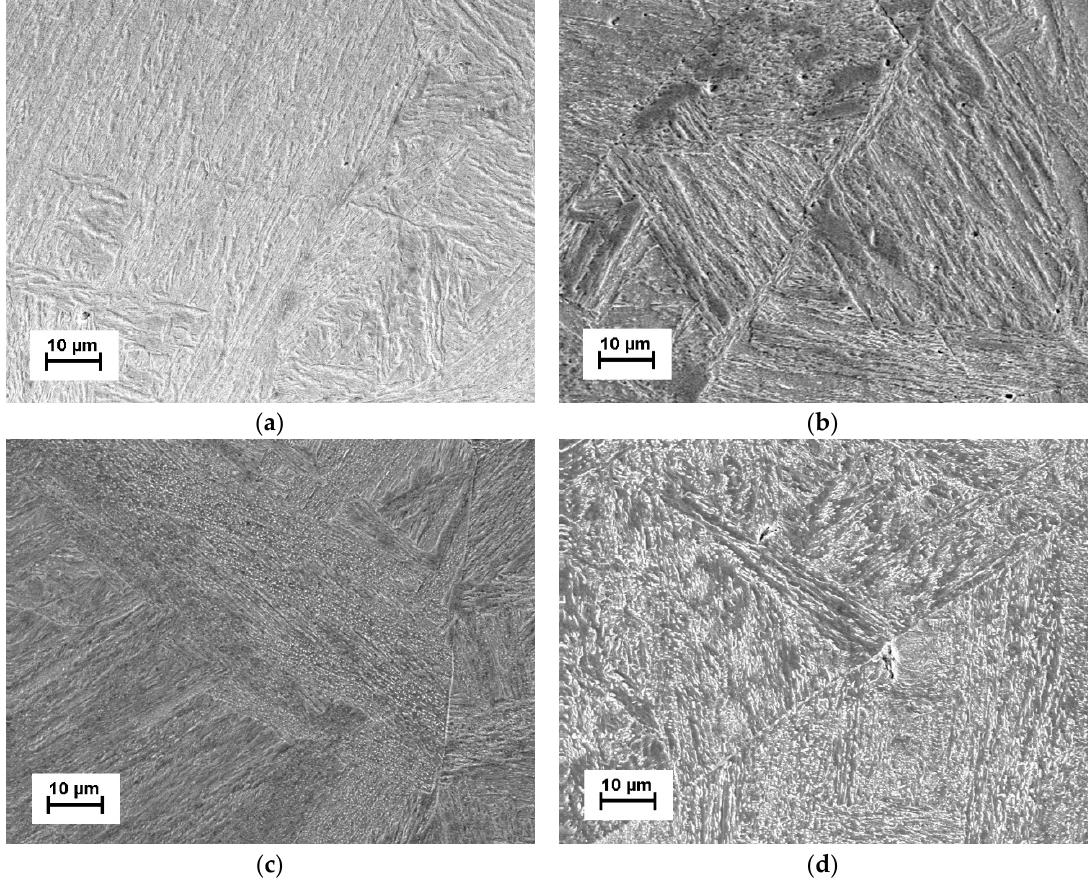
Figure 5. CGHAZ microstructure: ( a ) t 8/5 = 2.5 s; ( b ) t 8/5 = 15 s; ( c ) self-tempering of martensite at t 8/5 = 30 s; ( d ) upper bainitic microstructure at t 8/5 = 100 s (M = 1000×, 2% HNO 3 ).